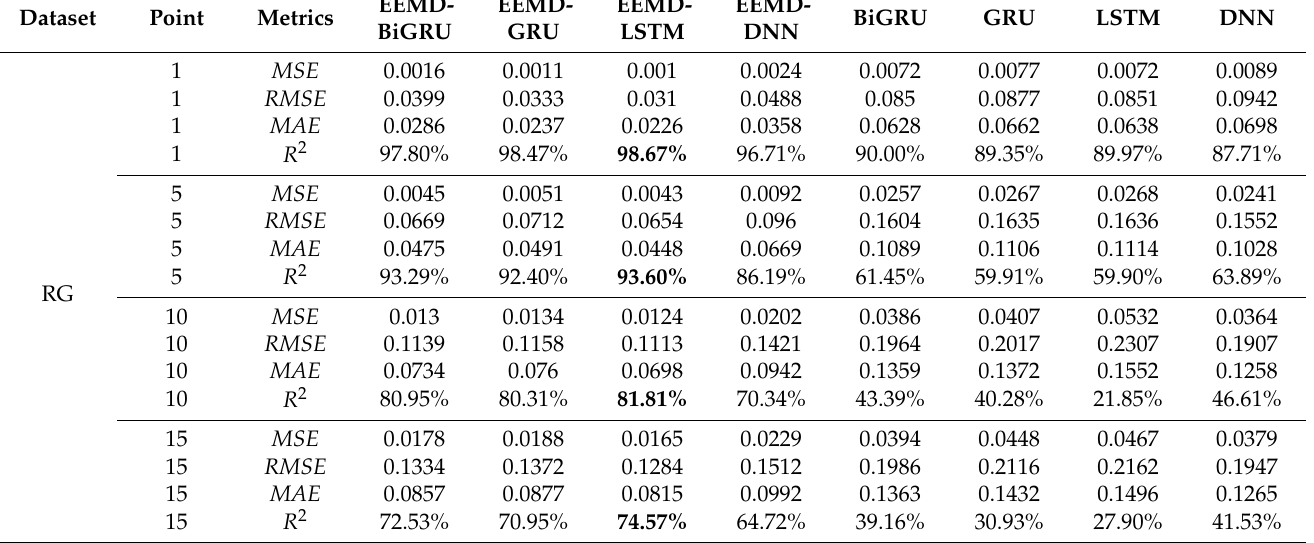
Table A2. Comparison results for the RG dataset using different algorithms.